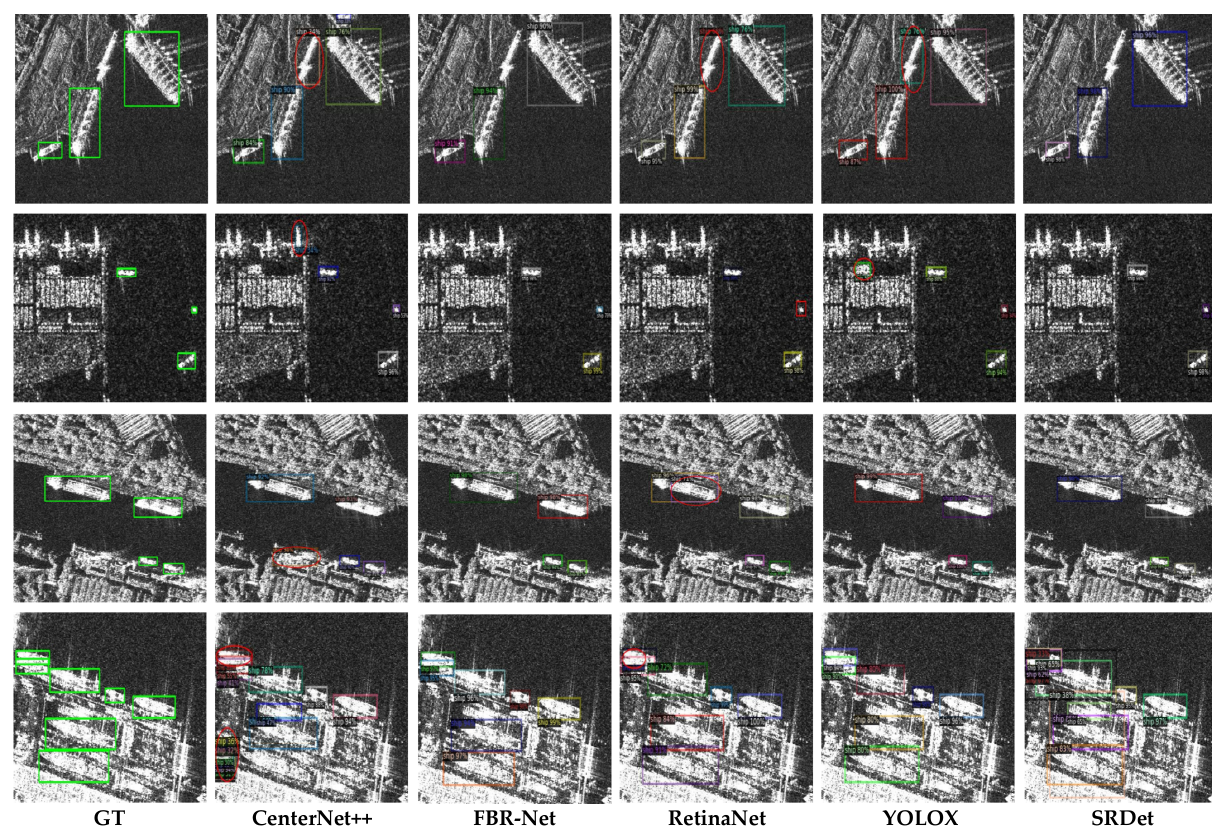
Figure 12. Visual comparison with one-stage object detection algorithms. Table 9. Comparison of the proposed model with existing one-stage detection algorithms.